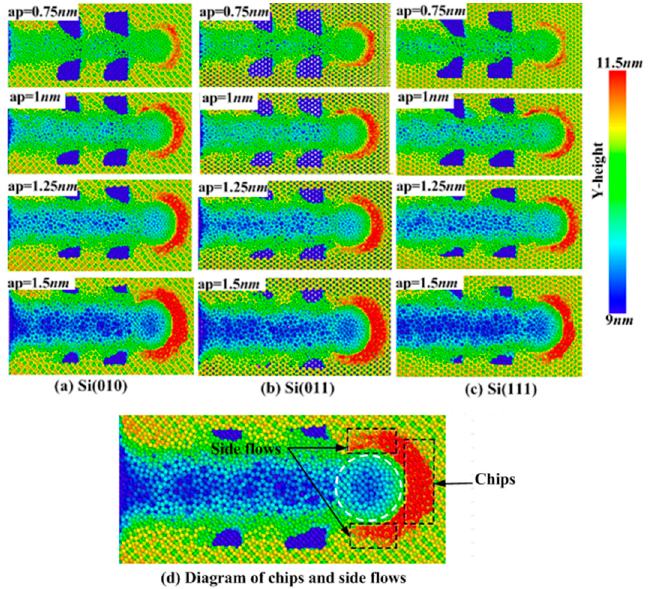
Figure 4. E ff ects of anisotropy on the surface morphology at di ff erent polishing depths (0.75 nm, 1 nm, Figure 4. Effects of anisotropy on the surface morphology at different polishing depths (0.75 nm, 1 1.25 nm, 1.5 nm, 1.25 nm, 1.5 nm).